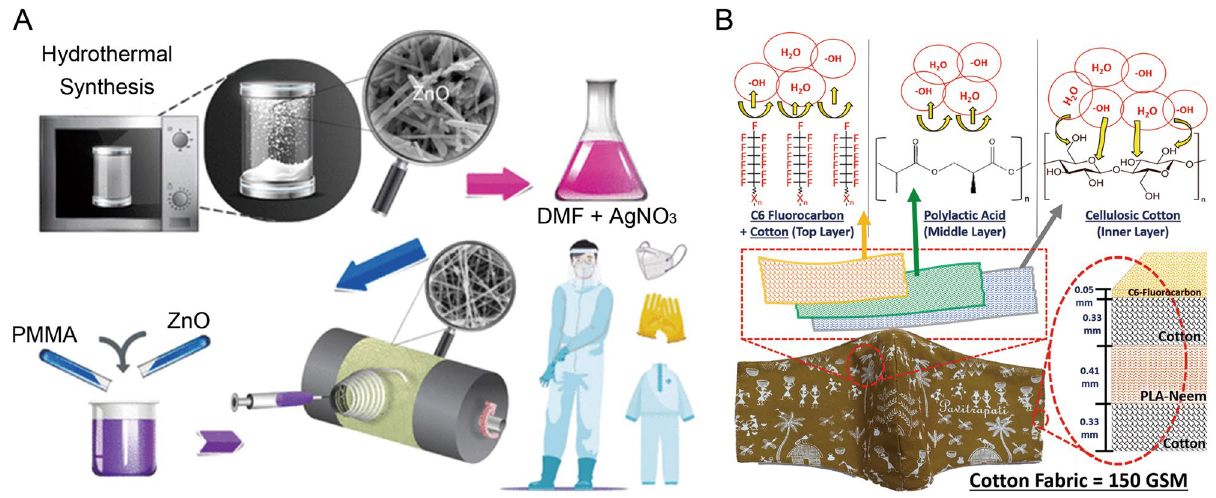
nanofiber filter layer by needle-less electrospinning is used to manufacture three-layer cotton-PLA-cotton layered